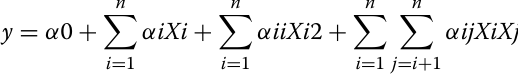
Data are represented as Mean a Relative Standard Deviation b Recombinant SAK with plasminogen c Recombinant SAK without plasminogen